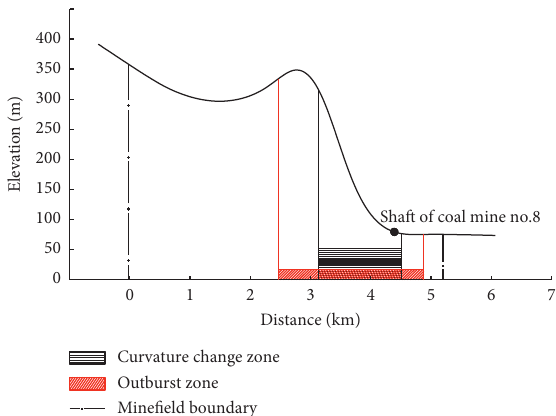
Figure 6: Relationship between terrain curvature change and coal and gas outbursts in mine no.